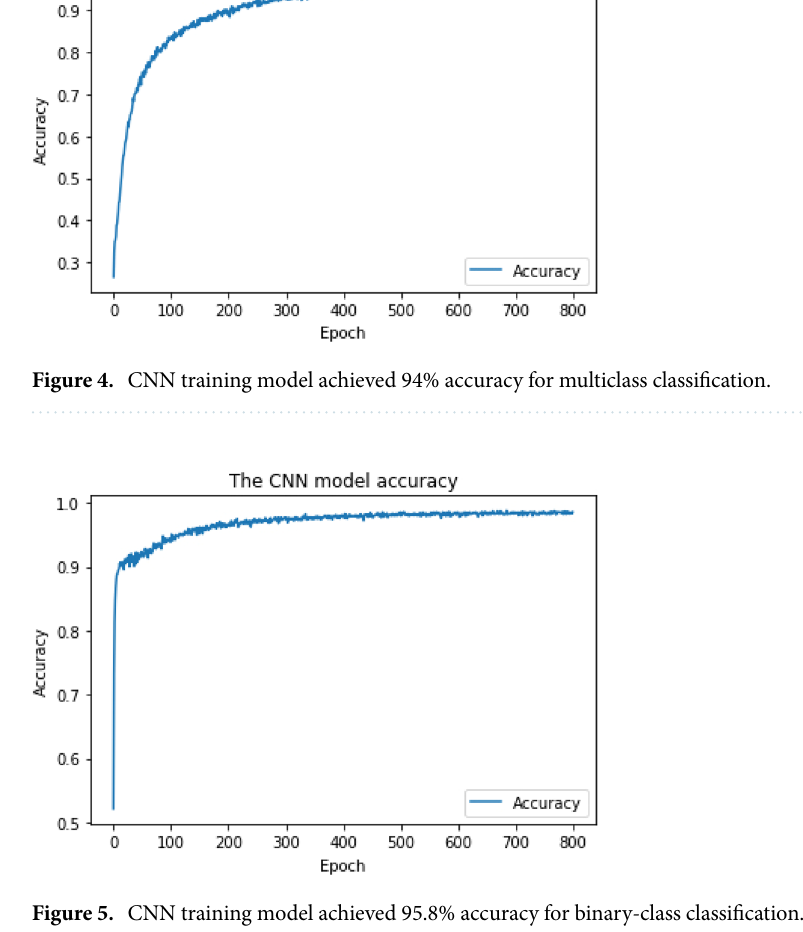
Figure 5. CNN training model achieved 95.8% accuracy for binary-class classification.